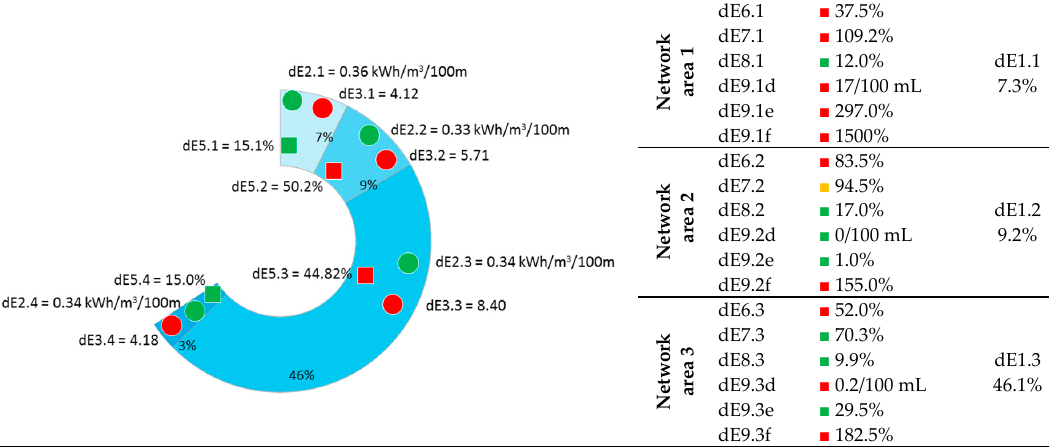
Figure 5. Energy consumption, energy efficiency and effectiveness in Utility K, for drinking water transport and distribution stage (level 3 of analysis) (the pie charts represent the energy consumption in each network area; the circles represent the energy efficiency PIs and the squares the effectiveness PIs).